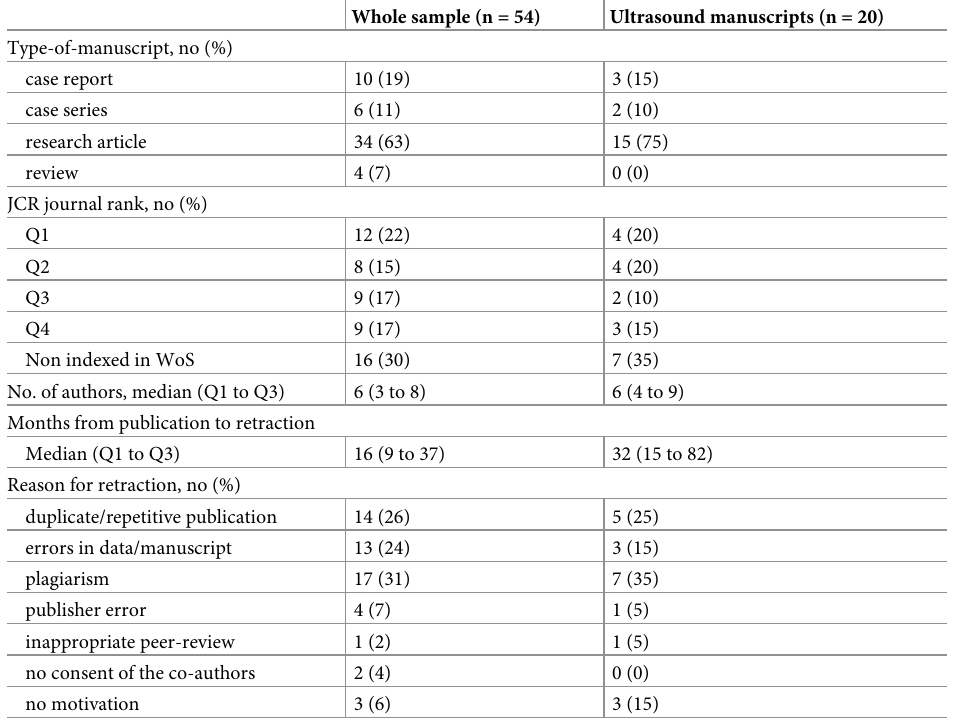
The WCI index varied from zero to 48.10 (a duplicate paper with 473 citations prior to prior retraction in 118 months) with no significant differences when the papers reporting US diag- nostic methods were compared to those that reported other radiology diagnostic methods (US: 0.81 (0.16 to 3.52), other methods than US: 0.87 (0.00 to 2.30), Mann-Whitney Test: P- value = 0.5972). The same pattern is observed on the WCI without significant differences post between papers reporting US diagnostic methods (0.53 (0.10 to 1.35)) as compared with the Table 1. Characteristics of the retracted manuscripts. Whole sample (n = 54) Ultrasound manuscripts (n =